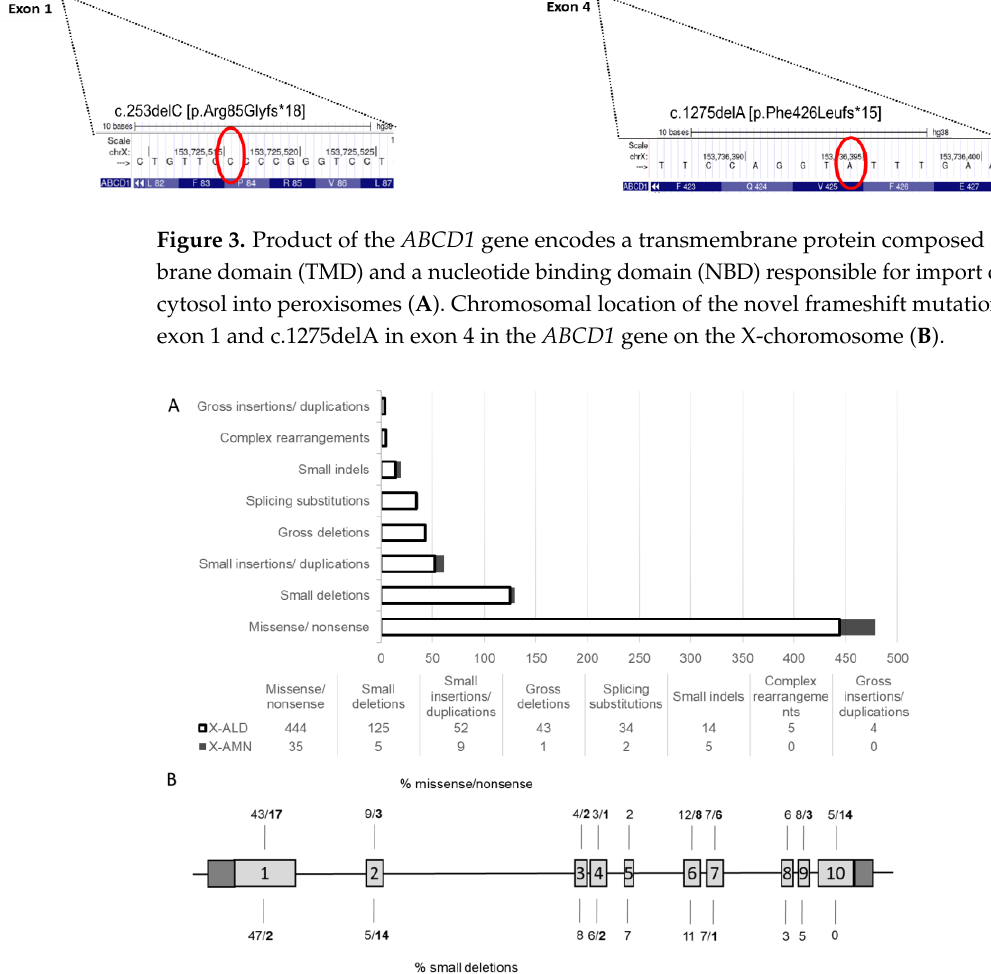
Figure 4. Schematic representation of all ABCD1 variants currently listed in the Human Gene Mutation Database [7] based on type of the reported gene variant ( A ), on gene location ( B ), and on disease phenotype ( A , B ). In B, the numbers in bold represent percentage of the rare AMN phenotype in the two most common variant types, missense/nonsense and small deletions.